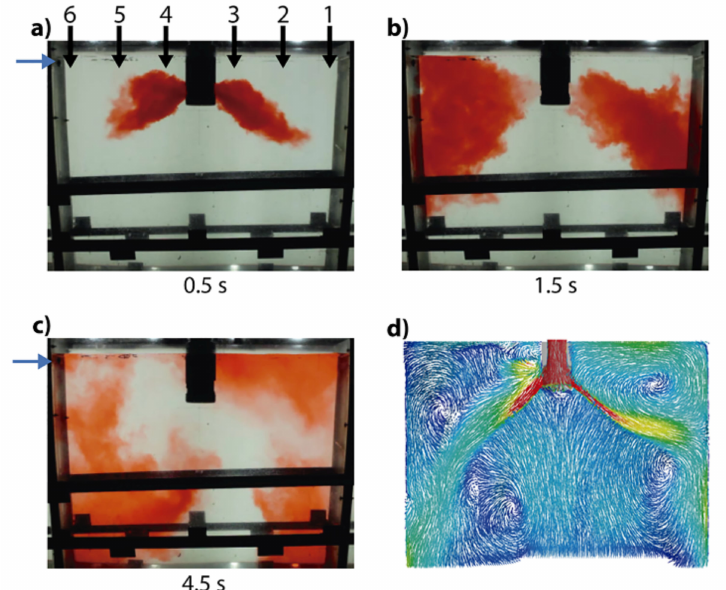
Figure 18. Tracer mixing in the mold model using nozzle B with clogging. ( a ) A total of 0.5 s after injection. ( b ) A total of 1.5 s after injection. ( c ) A total of 4.5 s after injection. ( d ) Numerical velocity field. The numbers indicate the position of the sensors and the blue arrows indicate the position of the ultrasonic